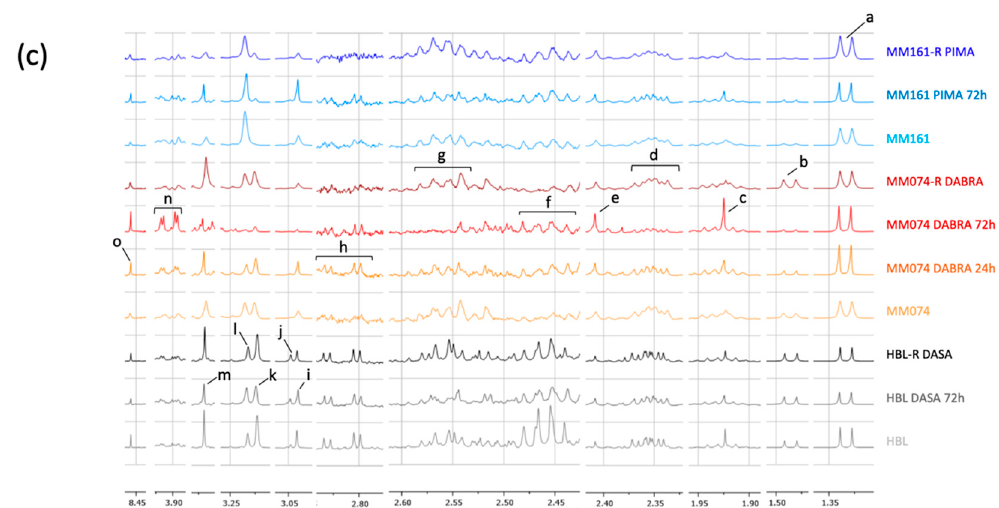
Figure 1. Scores plot ( a ) and loadings plot ( b ) of the partial least square analysis (PLS-DA) of the drug-free (MM074, MM161, HBL), short-time drug-exposed (MM074 DABRA 24 h, MM074 DABRA 72 h, MM161 PIMA 72 h, HBL DASA 72 h) and long-time drug-exposed (MM074-R DABRA, MM161-R PIMA, HBL-R DASA) cellular extracts (R 2 X = 0.929; R 2 Y = 0.527; Q 2 cum = 0.415). ( c ) NMR spectra of the IC compartments highlighting the discriminant-identified metabolites. For the sake of completeness, spectra were normalized against the total AUC to visualize the relative intensities of each metabolite between the groups. The metabolites were identified and tagged as follows: a: Lactate; b: Alanine; c: